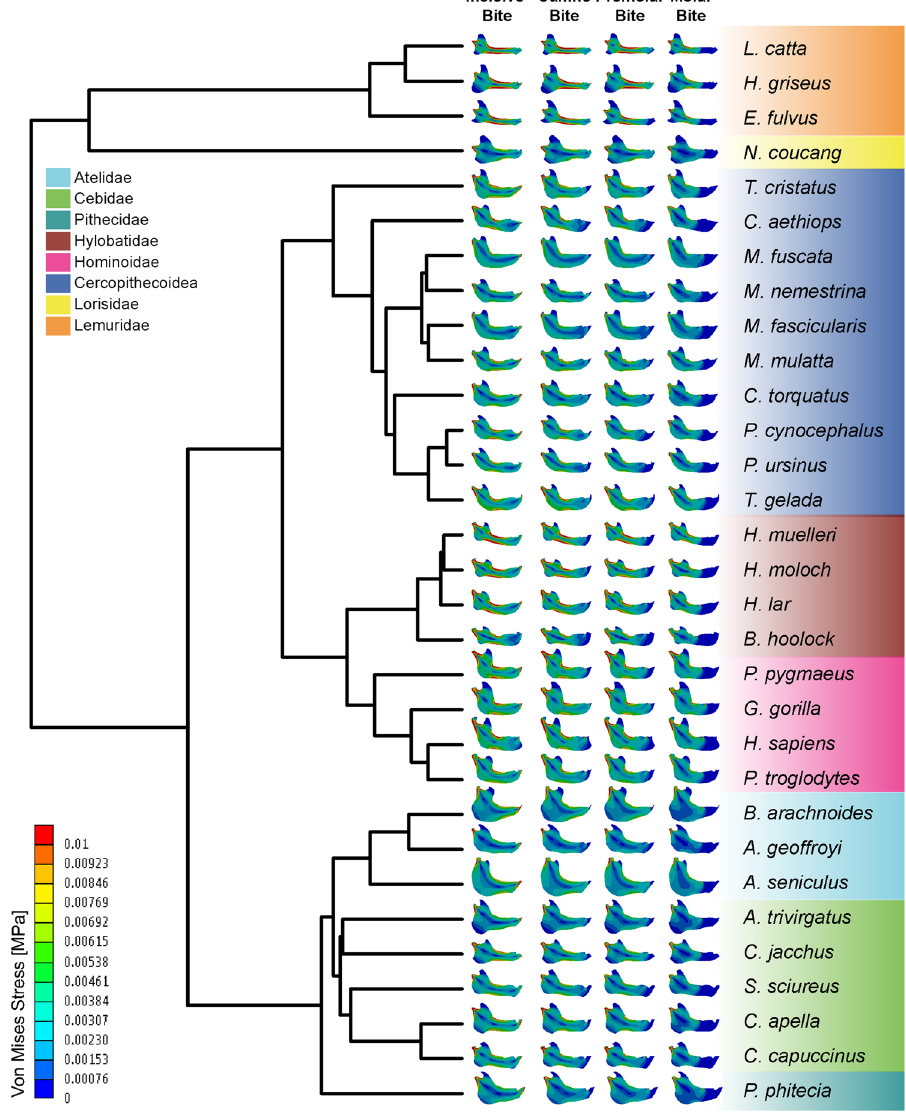
Figure 2. Phylogenetic tree and von Mises Stress distribution for each specimen under the four different bite cases: IB: incisive bite; CB: canine bite; PB: premolar bite and MB: molar bite. Phylogenetic tree from